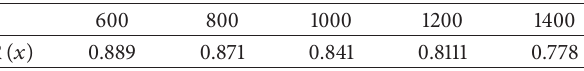
Table 3: Reliability degree of electric vehicle motor under different running time.